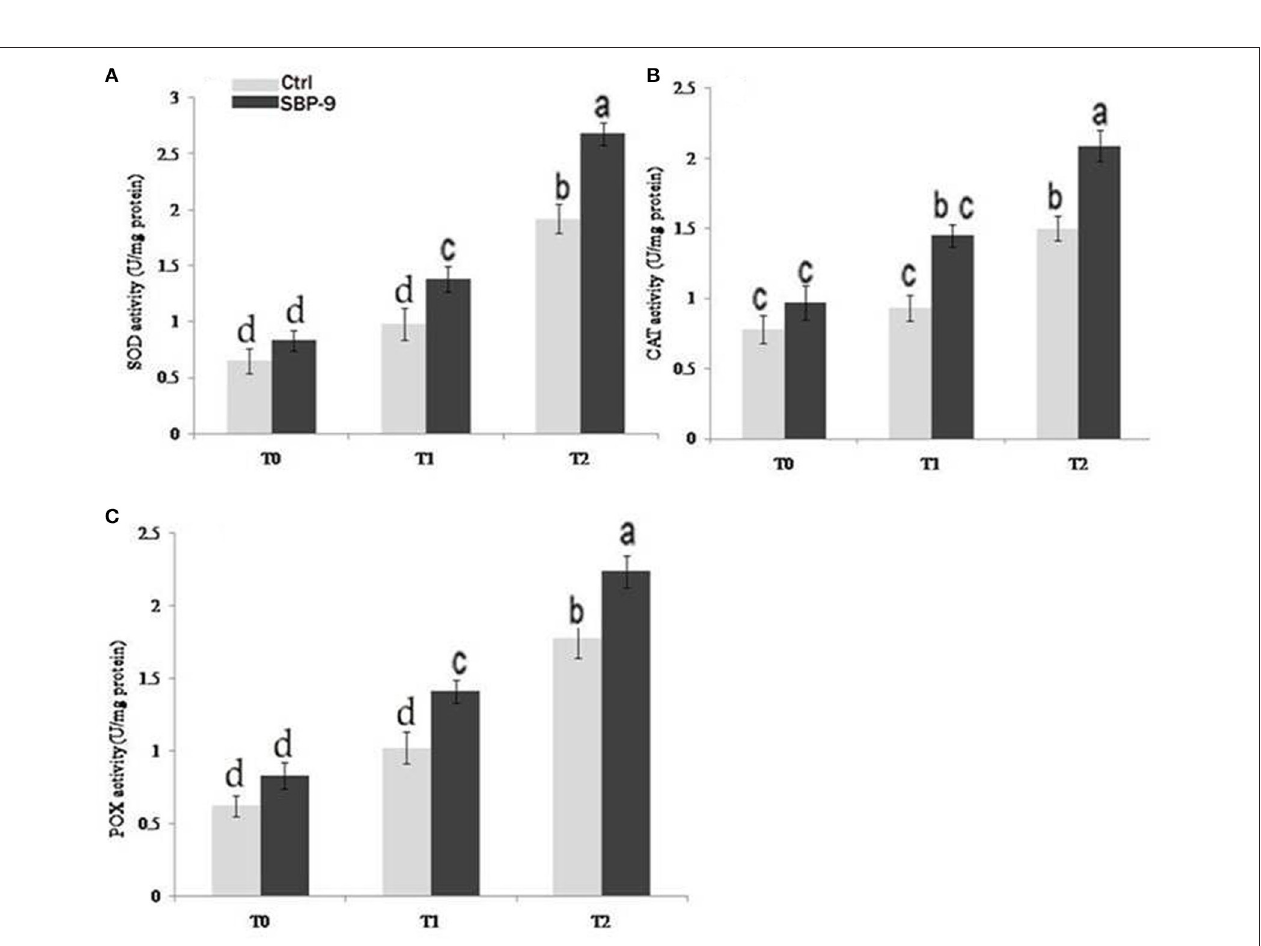
FIGURE 6 | Effect of NaCl and SBP-9 inoculation on the antioxidant activities under tested treatments T-0, T-1, T-2; (A) Super-oxide dismutase (SOD) (B) Catalase (CAT) (C) Peroxidase (POX). Each value is mean of three replicates ± SD. Different letters on the bar in each column represent the significant difference.